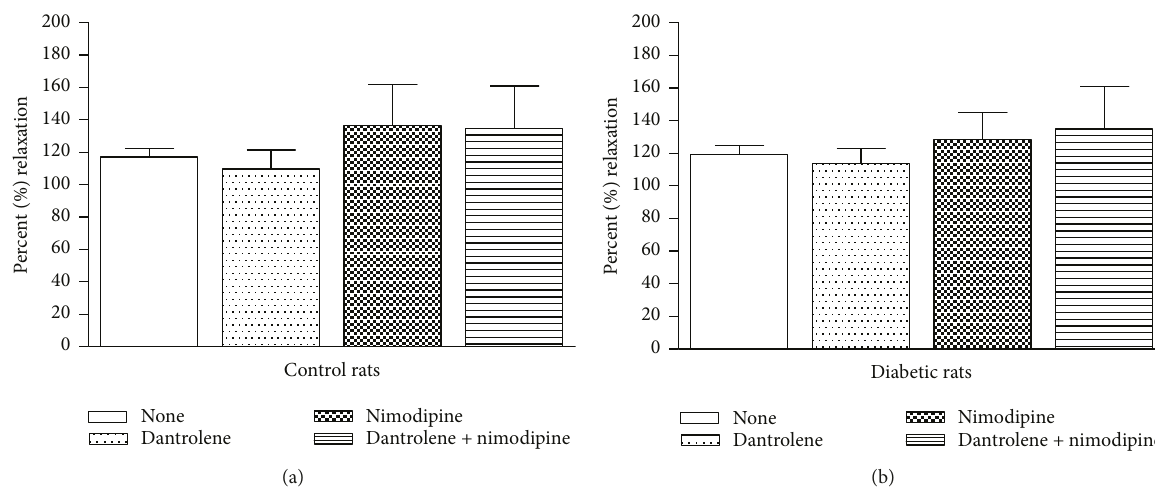
Figure 5: E ff ects of a 30min incubation period with 50 μ M dantrolene, with 50nM nimodipine, and with both drugs in combination on the endothelial-independent relaxation of aortic rings from control (a) and STZ diabetic rats (b). Aortic rings were precontracted with 0.1 μ M phenylephrine (PHE) before the addition of 1.0 μ m sodium nitroprusside (SNP) to directly relax the vascular smooth muscle. The values shown are the means ± SEM of 6 to 9 animals per group. Note that the drugs, either alone or in combination, did not modify endothelial- independent relaxation in control or STZ diabetic rats.